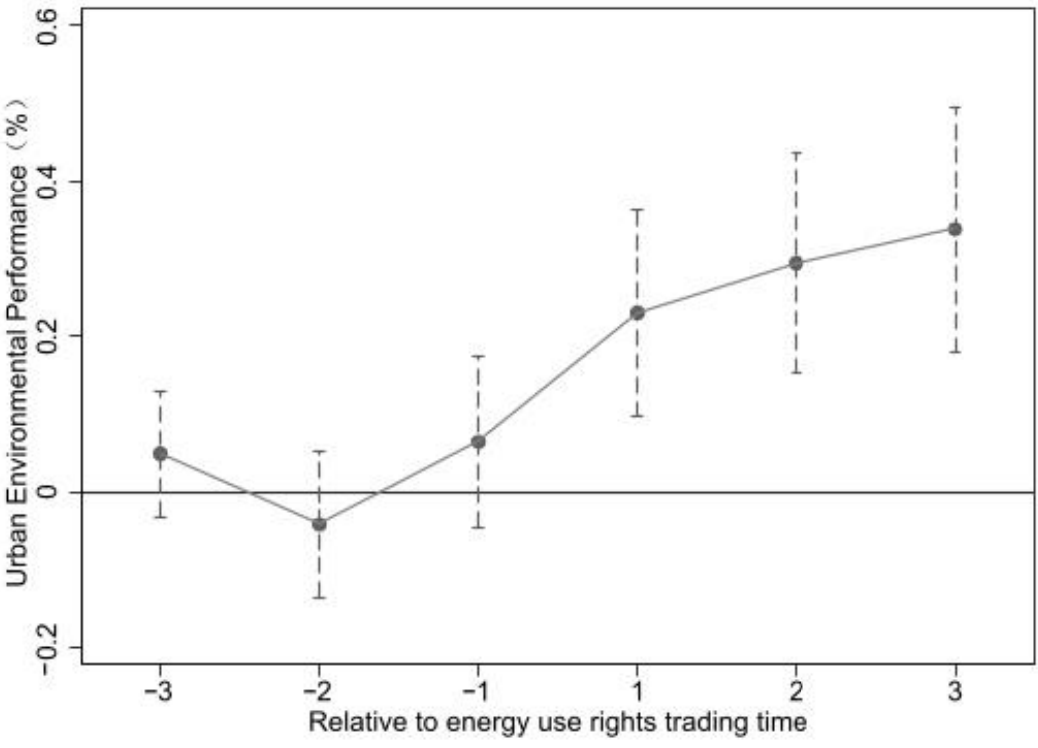
Figure 1. Parallel trend test.